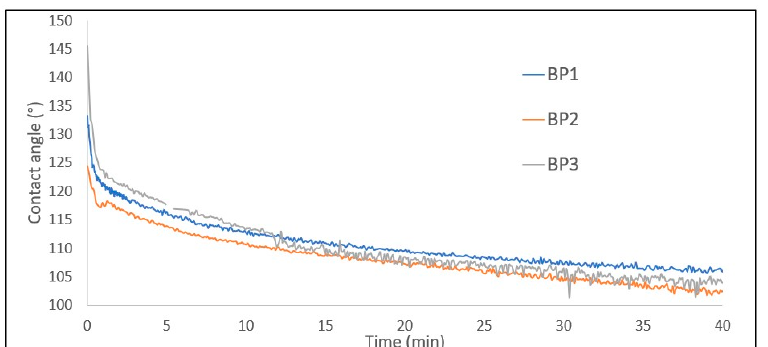
Figure 9. Measurement of the contact angle of a drop of red enamel on a BP through the Young- Laplace fitting for 40 min after it was placed on three different BPs.